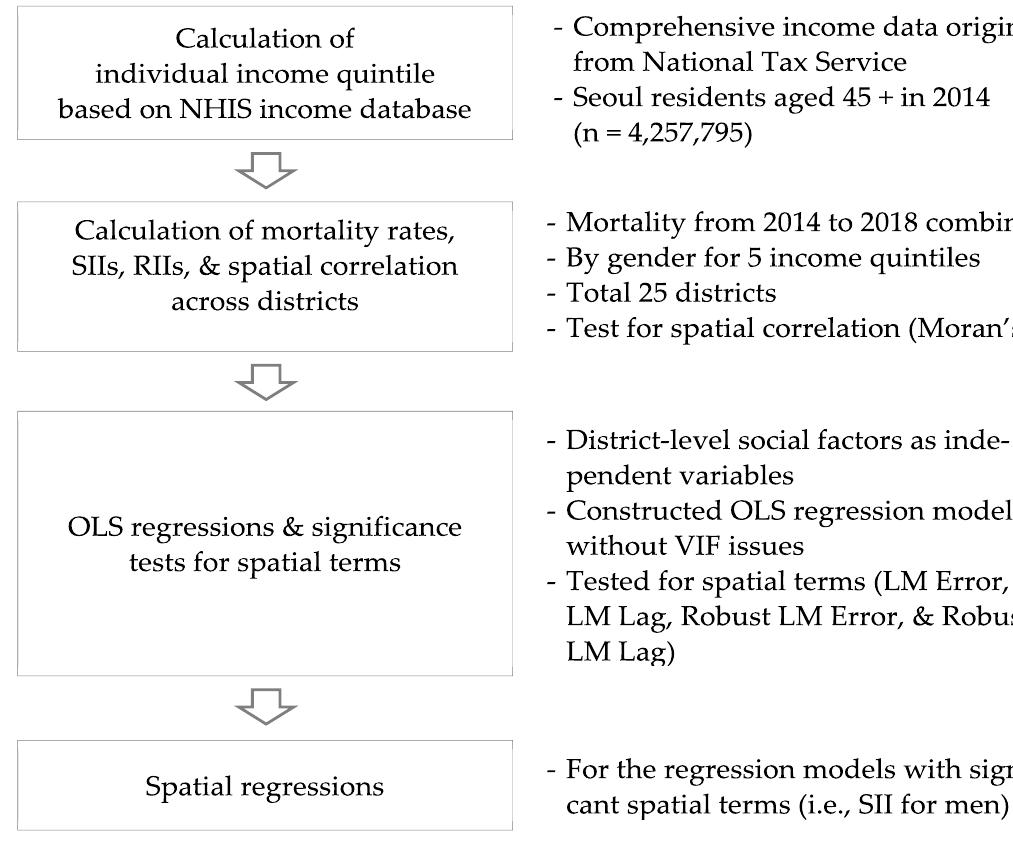
Figure 1. Study design. Figure 1.